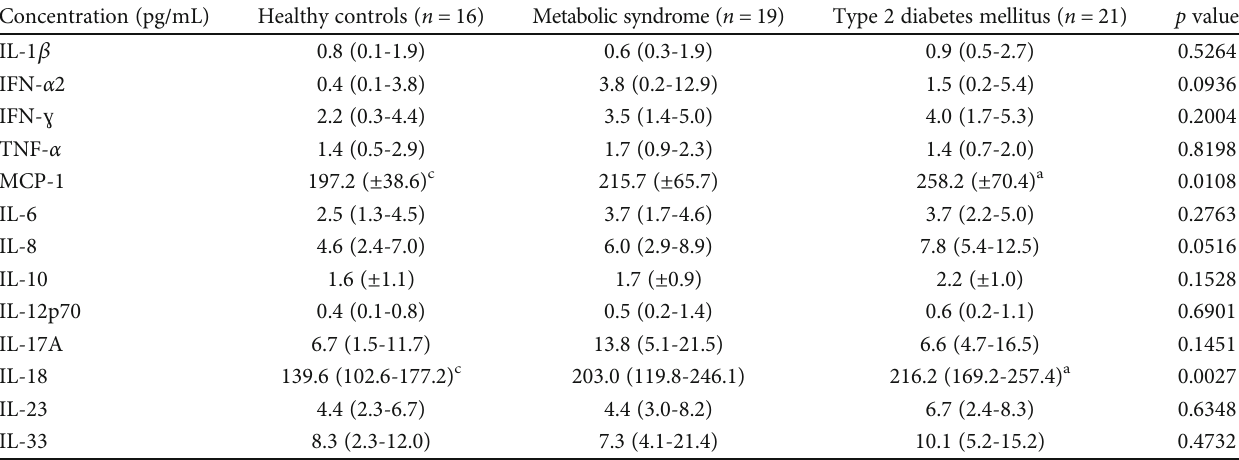
Table 4: Cytokine pro fi le in children and adolescents with type 2 diabetes mellitus, metabolic syndrome, and healthy controls. Concentration